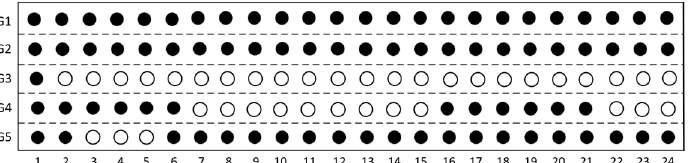
Figure 13. Commitment status of units with 30% penetration of wind power generation.